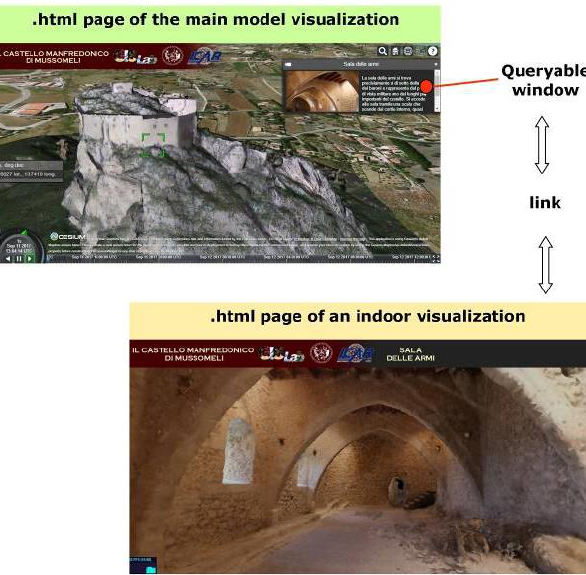
Figure 11. The link function between main 3D model and an indoor environment